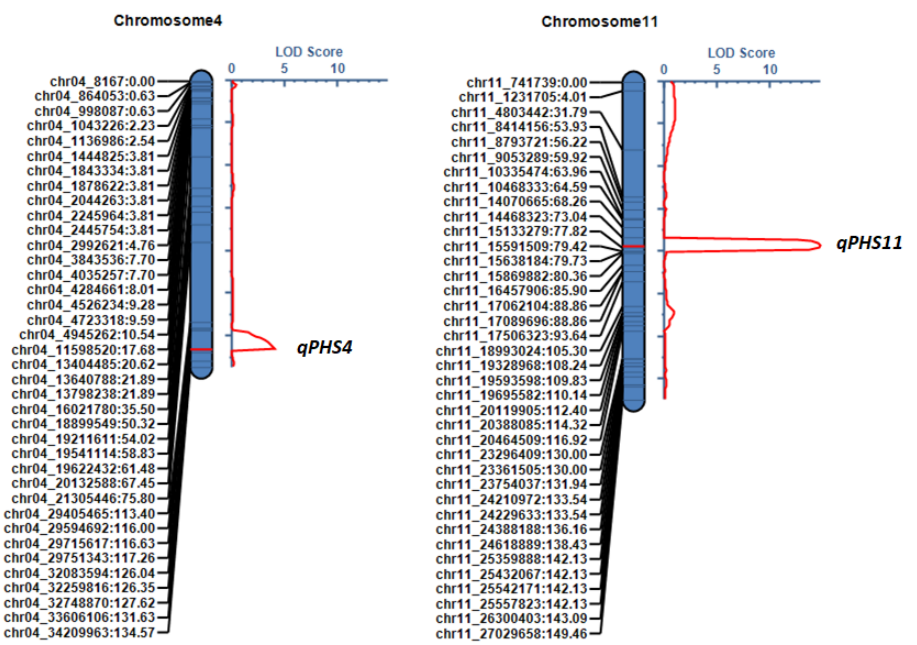
Figure 6. Positions of two QTLs affecting preharvest sprouting (PHS) rate in the genetic map of 162 RILs derived from the cross Odae × Joun. The names of each marker and their genetic distances from the first marker at the top of each chromosome are shown on the left-hand side. The LOD score (red line) is shown on the right-hand side.